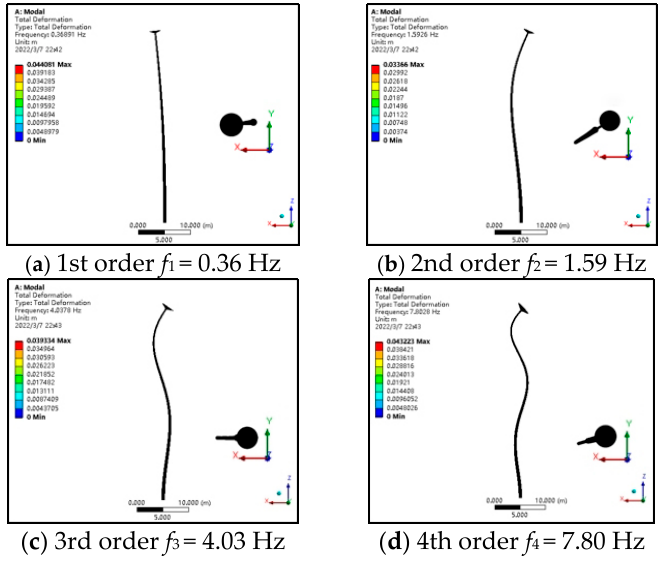
Figure 9. The first four vibration modes of the light pole structure.